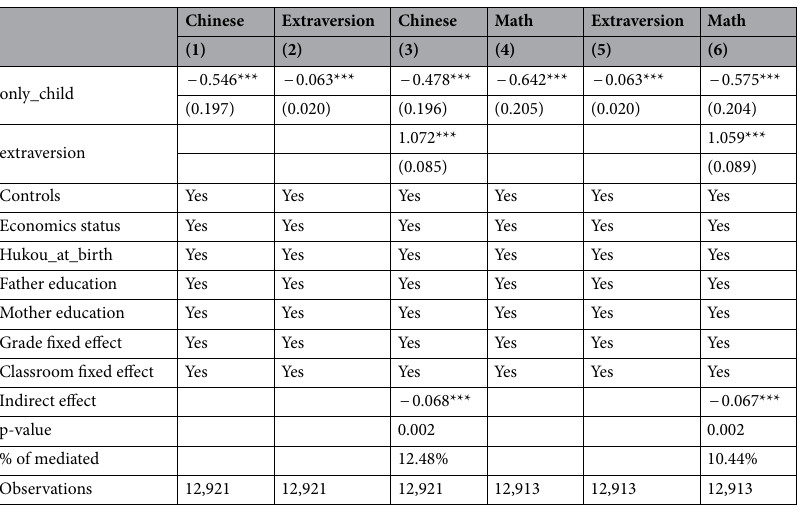
Table 11. Mechanism: Extraversion. Notes: Standard errors in parentheses, adjusted for within-classroom clustering. * p < 0.10. ** p < 0.05. *** p <